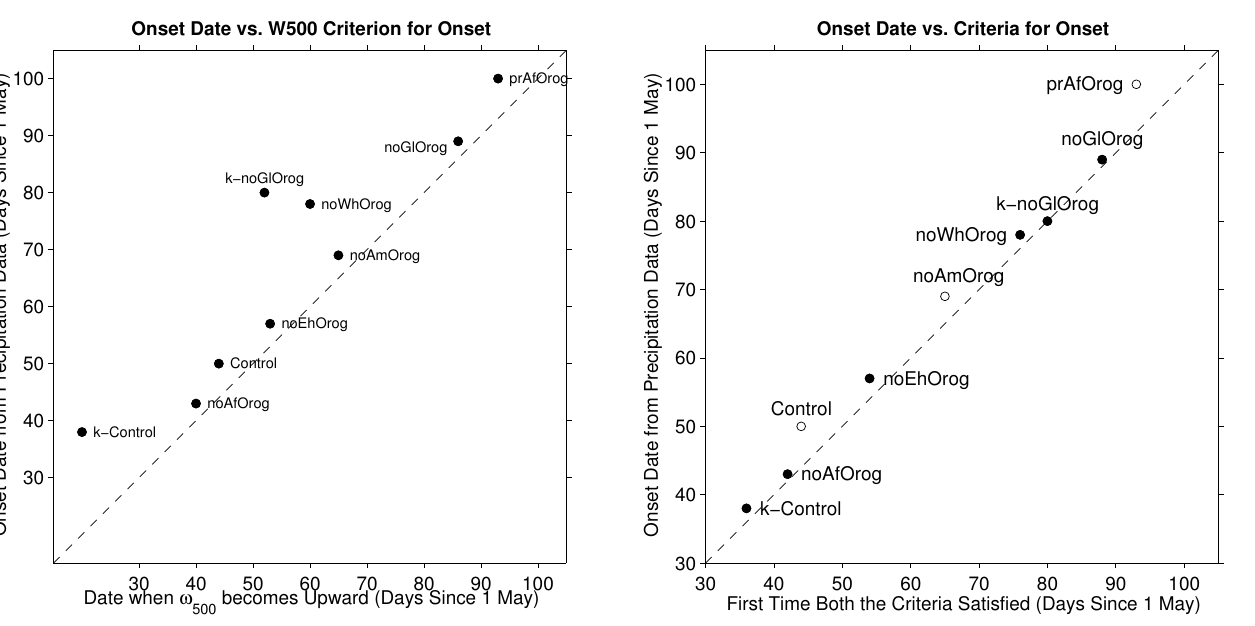
Fig. 21. Onset date vs. second necessary criterion ( W500 ) for onset. Key words starting with k- indicates simulation with Kuo cumulus convection.